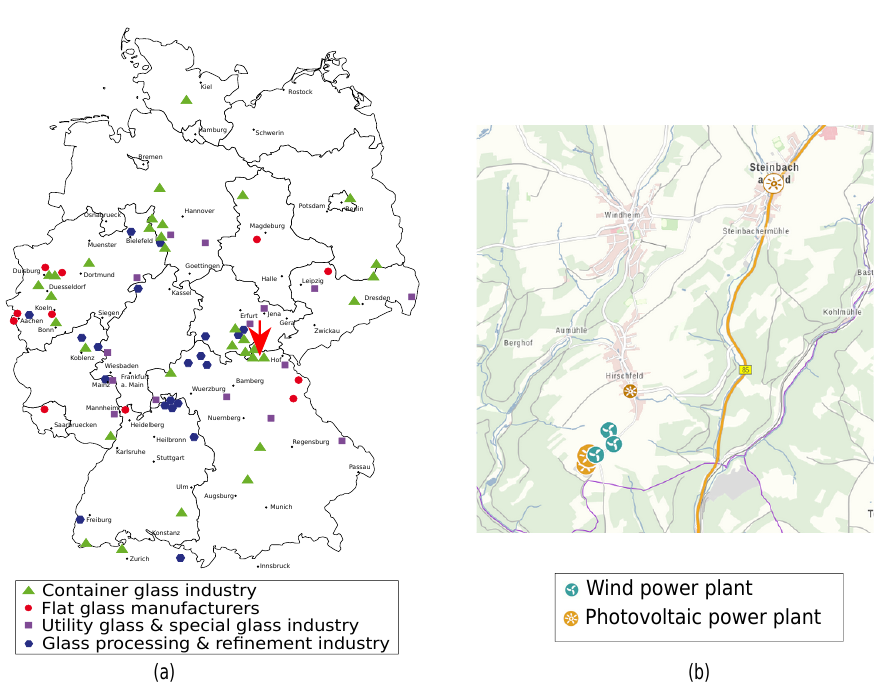
Figure 4. ( a ) Distribution of the glass industry in Germany, highlighting the selected location (red arrow, Steinberg am Wald) for the case study of the exemplary evaluation of CO 2 abatement costs [1]. ( b ) Emergence of renewable energy in the vicinity of the selected case study site (i.e., Steinberg am Wald, latitude: 50.404387°, longitude: 11.332333°, WGS84 coordinates)